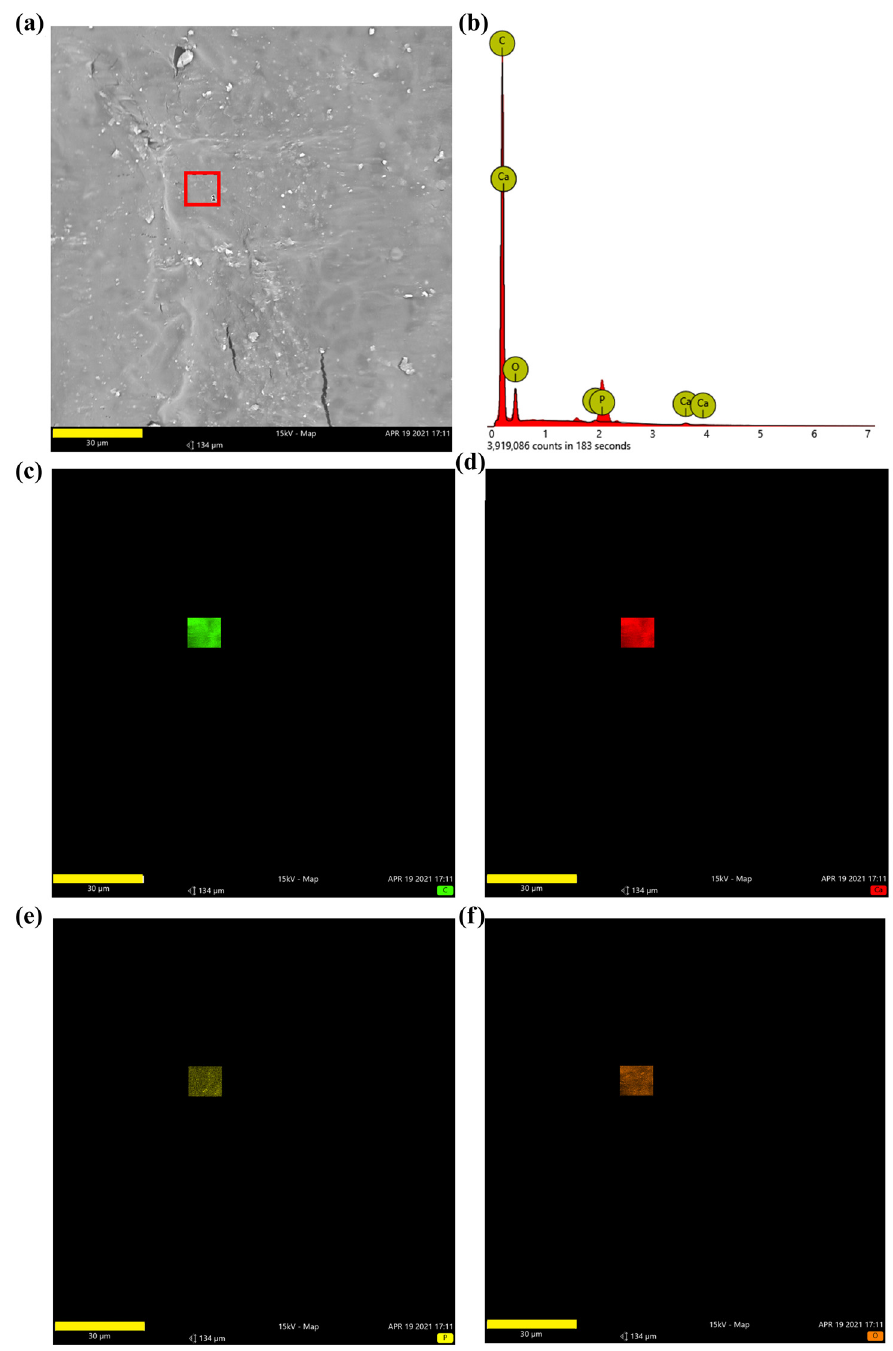
Figure 3: Composition of composite material. ( a ) EDS was used to detect the composition and element distribution in the rectangular area ( marked in red ) on the surface of the composite material; ( b ) carbon ( C ) , calcium ( Ca ) , phosphorus ( P ) , and oxygen ( O ) were detected in the composite material; and ( c – f ) the distribution of C, Ca, P, and O ( bar = 30 μ m )